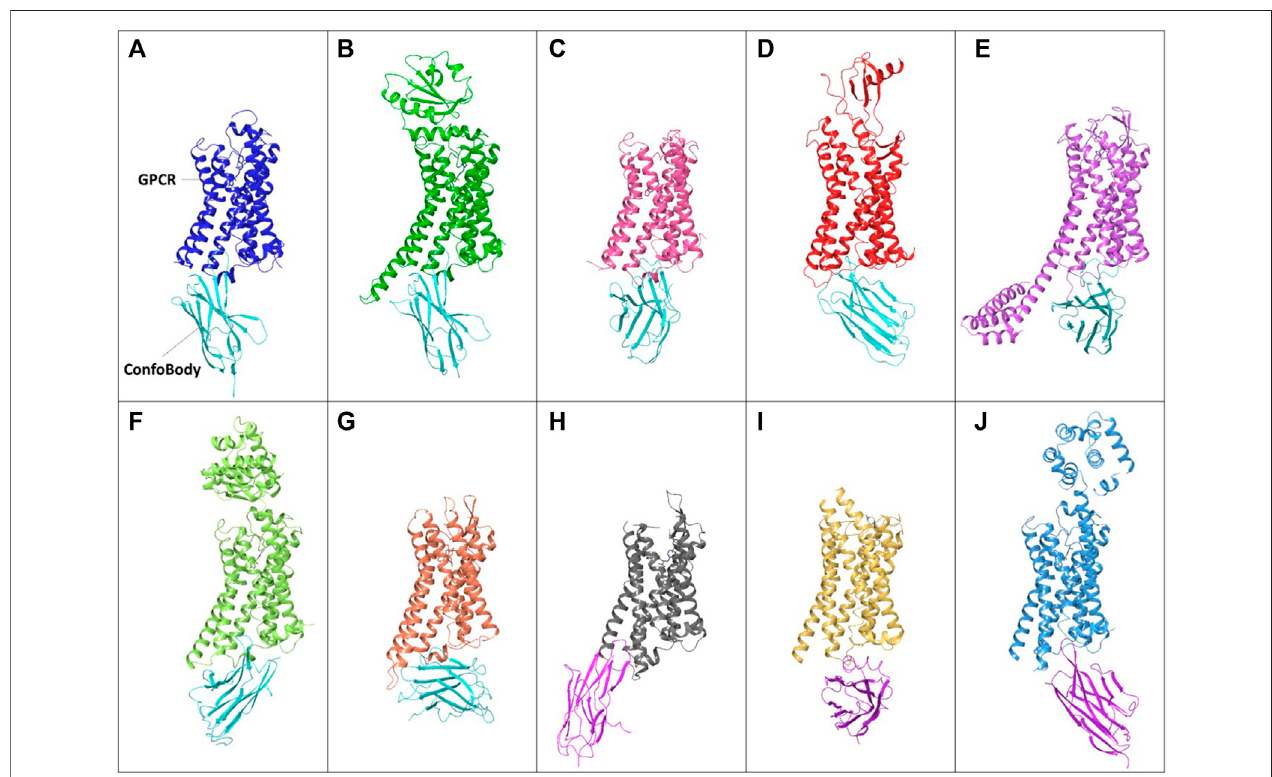
FIGURE 5 | Examples of unique published ConfoBodies used to solve Class A GPCR active state structures (depicted by cyan ConfoBodies) and inactive state structures (depicted by magenta ConfoBodies). (A) Nb80 with ADRB2 (blue) PDB = 3P0G. (B) Nb6B9 with ADRB1 (green) PDB = 6H7N. (C) Nb9-8 with ACM2 (pink) PDB = 4MQS. (D) Nb7 with US28 (red) PDB = 4XT1. (E) Nb.AT110i1 with AGTR1 (magenta) PDB = 6OS2. (F) Nb71 with ADRB2 (lime) PDB = 6MXT. (G) Nb39 with OPRM1(orange)PDB=5C1M. (H) Nb6*withOPRK1(silver)PDB=6VI4. (I) Nanobody6*withSUCR1(yellow)PDB=6RNK. (J) Nb60withADRB2(lightblue)PDB = 5JQH. *There are two Nb6 ConfoBodies deposited which are different. All GPCRs are structurally aligned to the backbone of the 3P0G GPCR